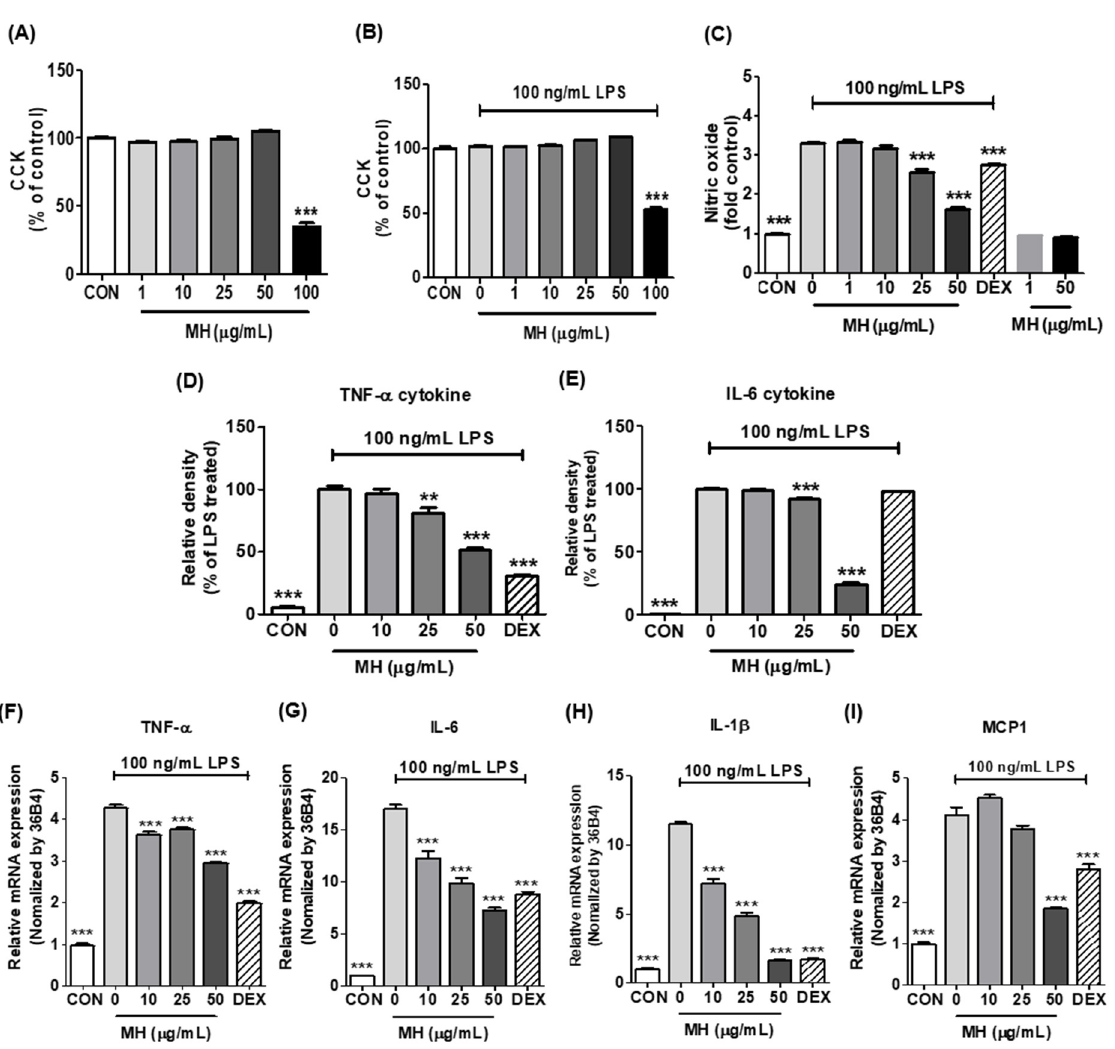
Figure 2. Effects of MH on the production of NO and inflammatory cytokines in LPS-stimulated BV2 cells. ( A ) Cell viability in BV2 cells treated with MH at the indicated concentrations for 24 h. ( B ) BV2 cells were treated with MH at the indicated concentrations for 1 h and then stimulated with LPS for 24 h. Cell viability was measured by the CCK assay. ( C ) BV2 cells were treated with MH at the indicated concentrations or 10 µ M DEX for 1 h before stimulation with LPS for 24 h. NO production was measured by Griess reagent assays. ( D , E ) Inflammatory cytokines secretion and ( F – I ) mRNA expression of inflammatory cytokines in BV2 cells treated with MH at the indicated concentrations for 1 h and then stimulated with LPS for 6 h. Data are expressed as the mean ± SEM. ** p < 0.01 and *** p < 0.001 vs. LPS control.